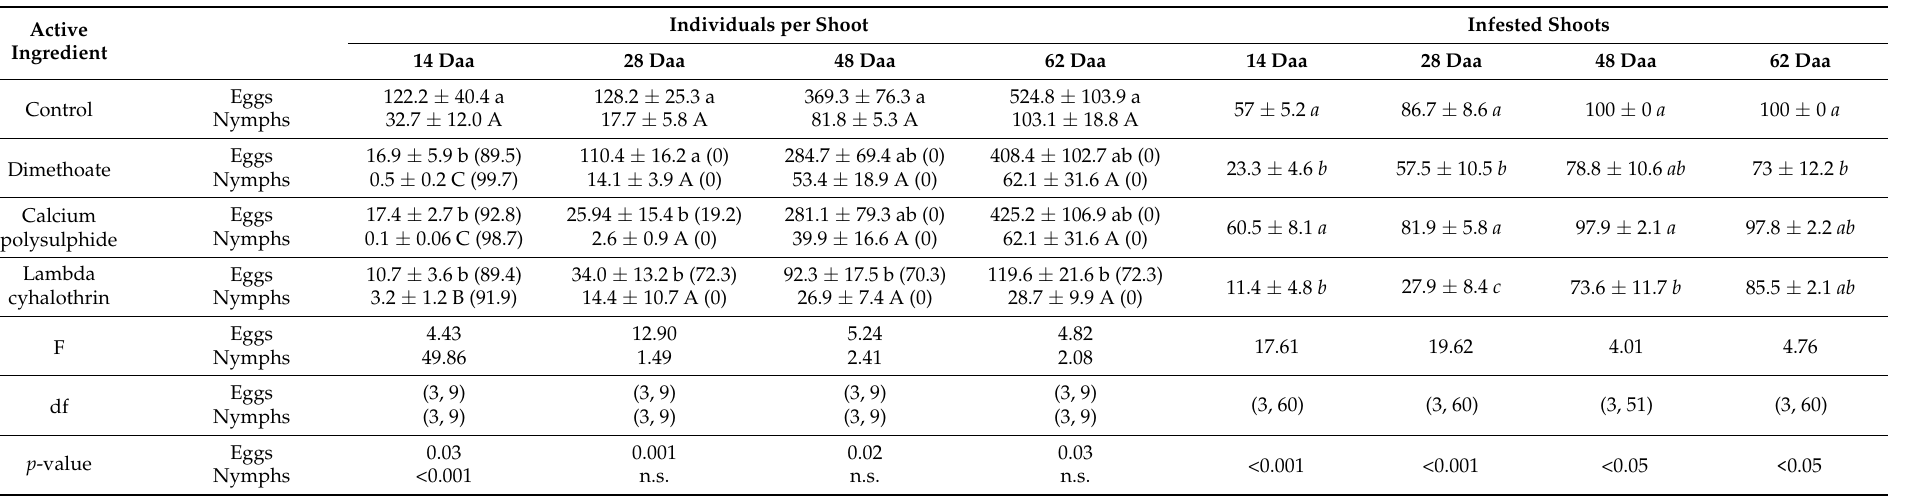
Table 5. Number of T. erytreae eggs and nymphs per shoot (mean ± standard error) and percentages of infested shoots at different times (14, 28, 48, and 62 days after application (daa)) in 2017 winter trial. In brackets, the percentage means of corrected mortality.